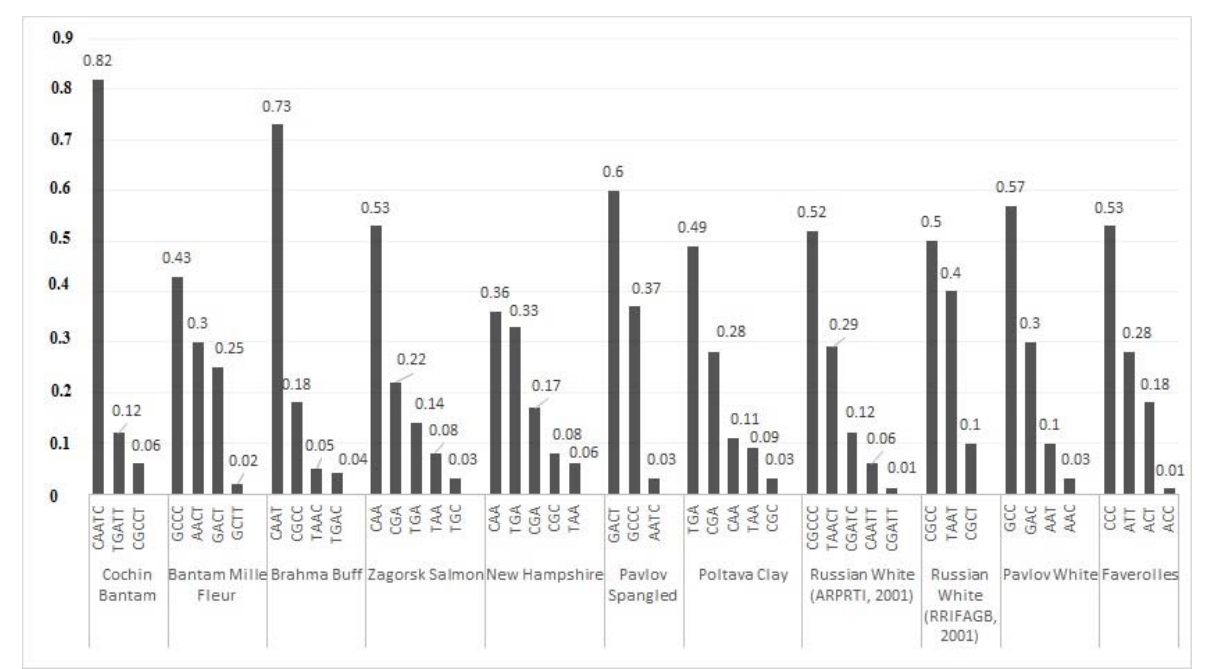
Figure 5. Distribution of haplotype frequencies in the 11 gene pool chicken populations.